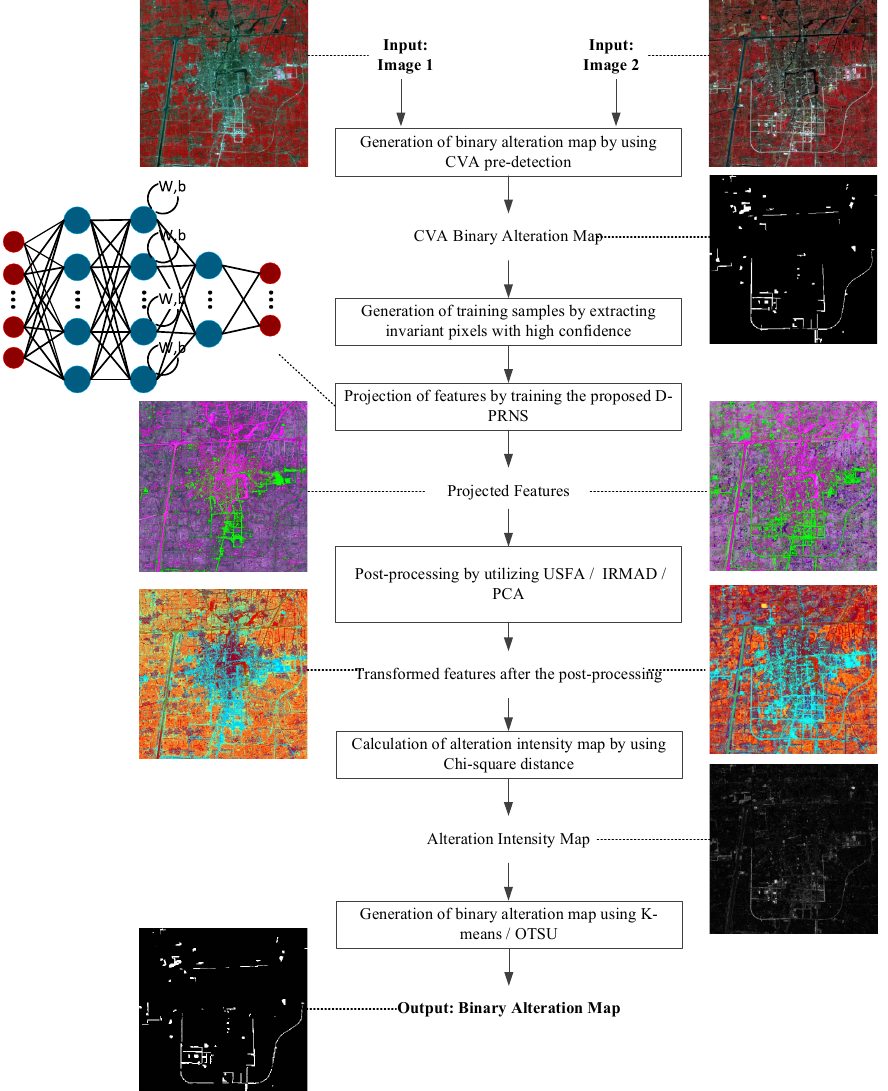
Figure 1. The proposed